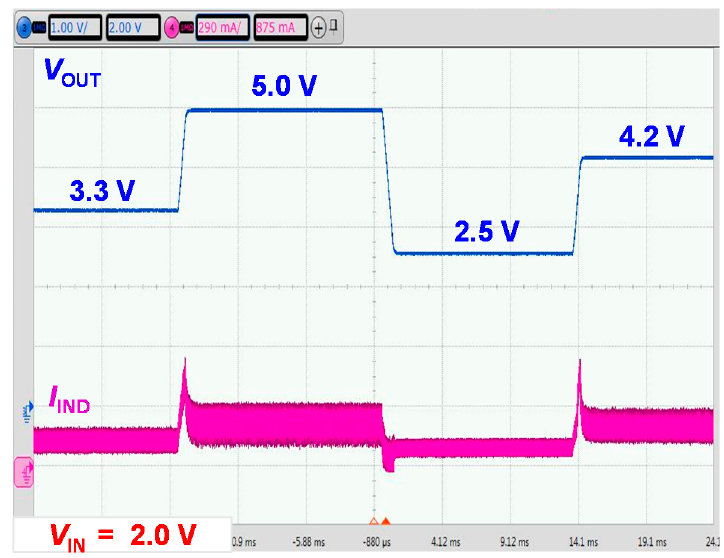
Figure 10. Measured dynamic output voltage scaling.